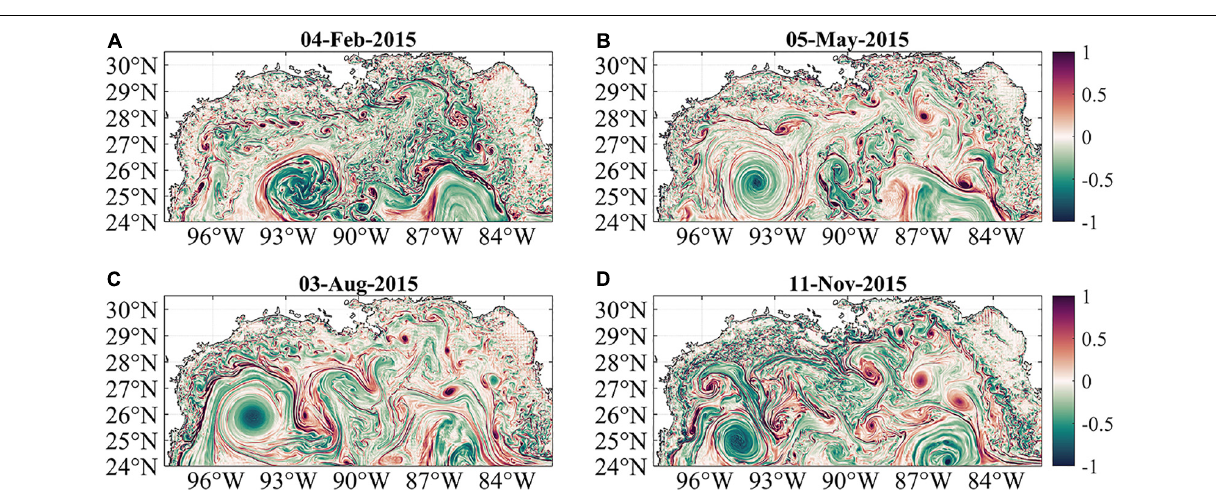
Frontiers in Marine Science |